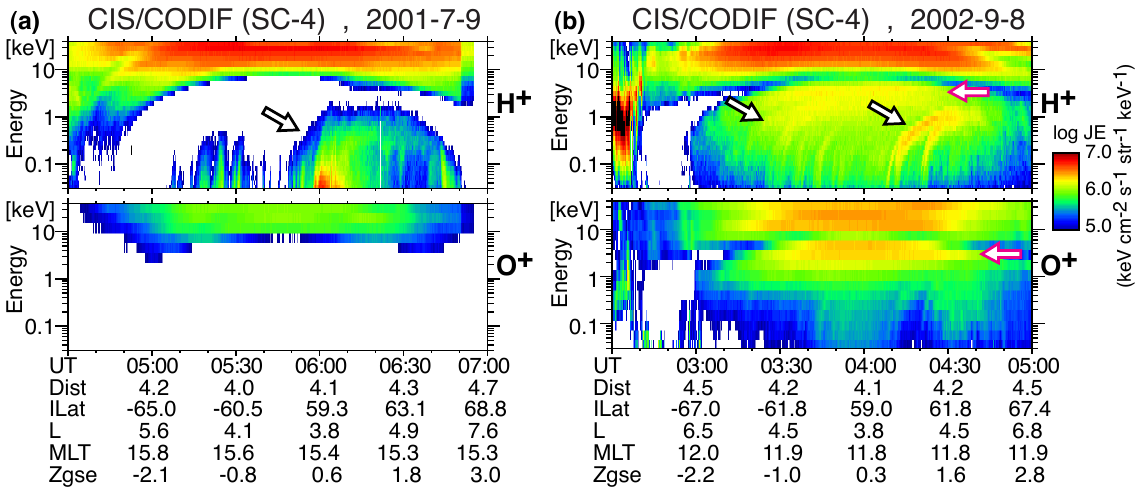
Fig. 1. Energy–time spectrograms of 4-pi averaged proton (H + , upper) and oxygen ion (O + , lower) differential energy fluxes observed by Cluster spacecraft-4 CIS/CODIF at 0.1–40keV during (a) 04:50–07:00UT on 9 July 2001, and (b) 02:30–05:00UT on 8 September 2002. The black empty arrows indicate the energy–latitude dispersed structure sub-keV ions that are simulated in this paper, and red empty arrows indicate mono-energetic keV ions that are discussed in Yamauchi et al.